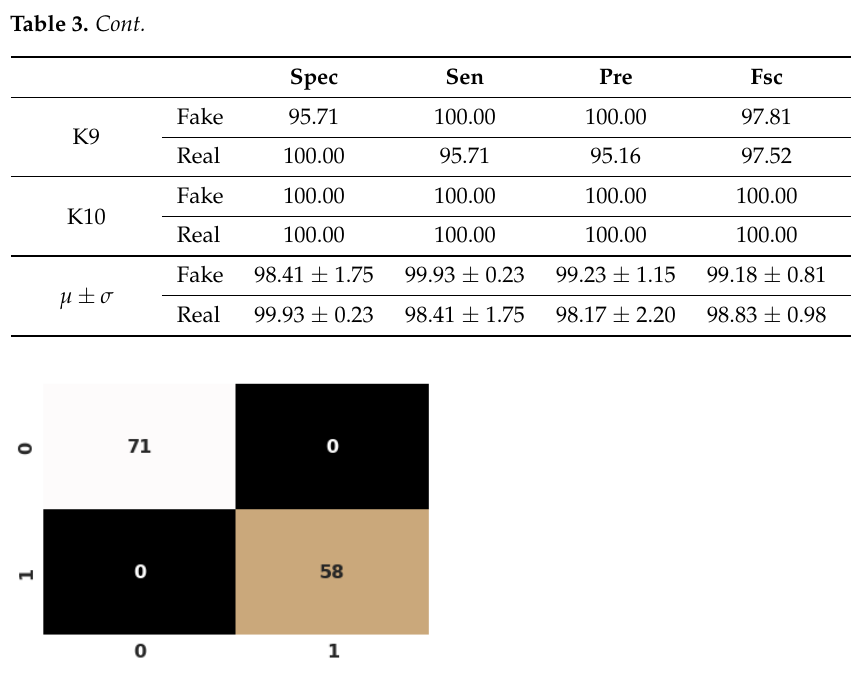
Figure 5. Confusion matrix for test split of 10th fold.